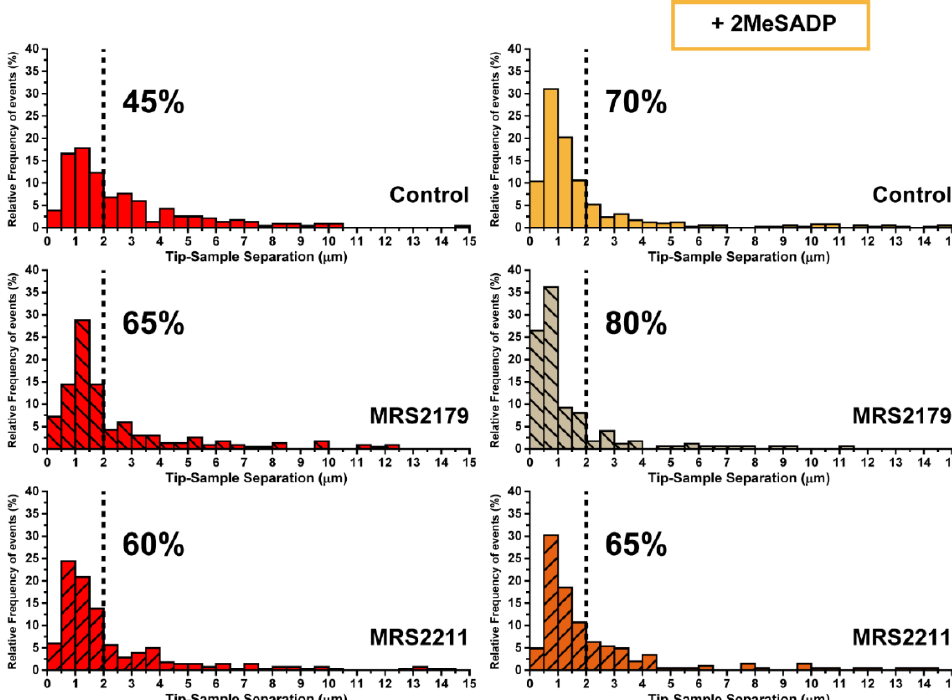
Figure 6. Characterization of ADP receptor mediating 2MeSADP effects observed in cerebellar astrocytes (II). Pulling distance-dependent relative frequency of appearance of full rupture for astrocytes ( N > 15) exposed to either MRS2179 and MRS221 or their subsequent interaction with 2MeSADP receptor agonist. Dashed line highlights the position at which observation of the 70% of the tethers in 2MeSADP treated control cells takes place.